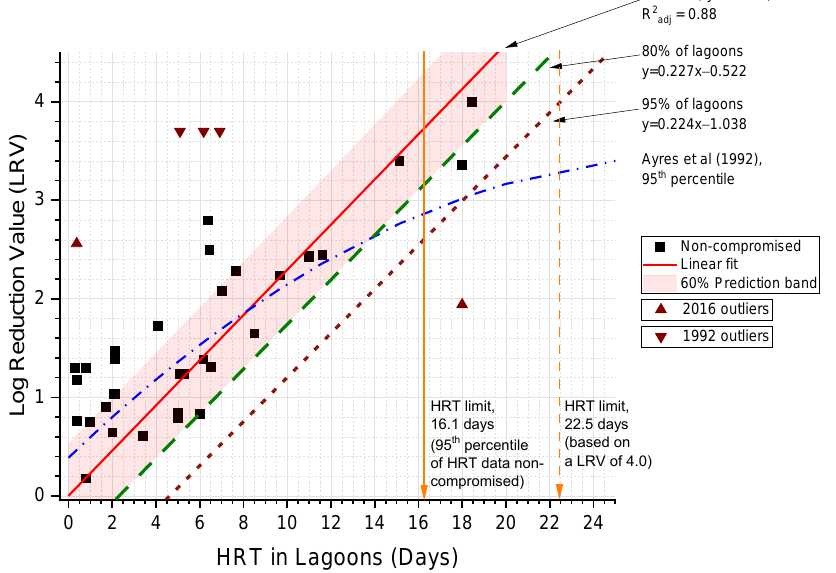
Figure 4. Log reduction value (LRV) design equation proposed for lagoons designed for wastewater stabilization. The green long-dashed line represents what 80% of lagoons would achieve (i.e., the lower 60% Prediction band) and is proposed for lagoons with a high level of design and management; data from [12]). The LRV equation for 95% of lagoons (brown short-dashed line) was the design equation originally proposed [12]. The blue dot-dash line is the 95th percentile design equation originally proposed [45]. Hydraulic retention time (HRT) limits are discussed in the text.